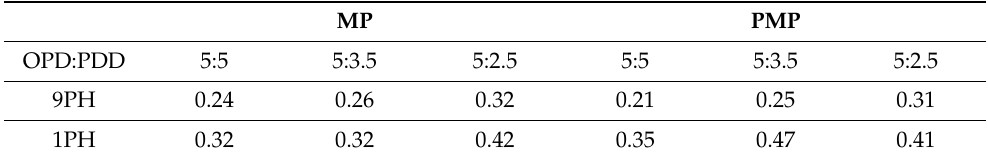
Table 1. Detection limit (wt. %) for single pinhole and multi-pinhole configurations with magnifications in both MP and PMP geometries. Results are shown for the third layer in both geometries.